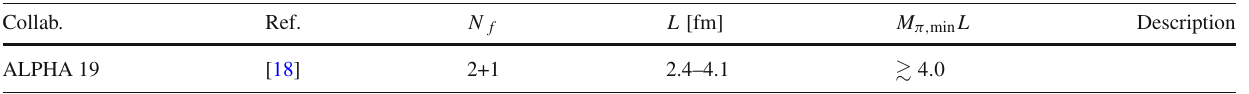
Table 84 Finite-volume effects in determinations of m ud , m s and, in some cases m u and m d , with N f = 2 + 1 quark flavours Collab. Ref.